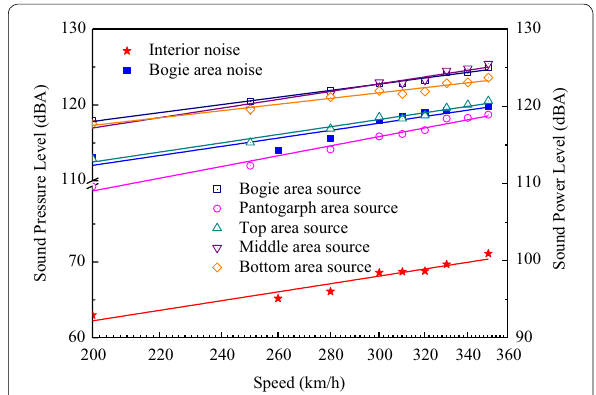
Figure 10 Relationships between the exterior noise and the interior noise at different speeds